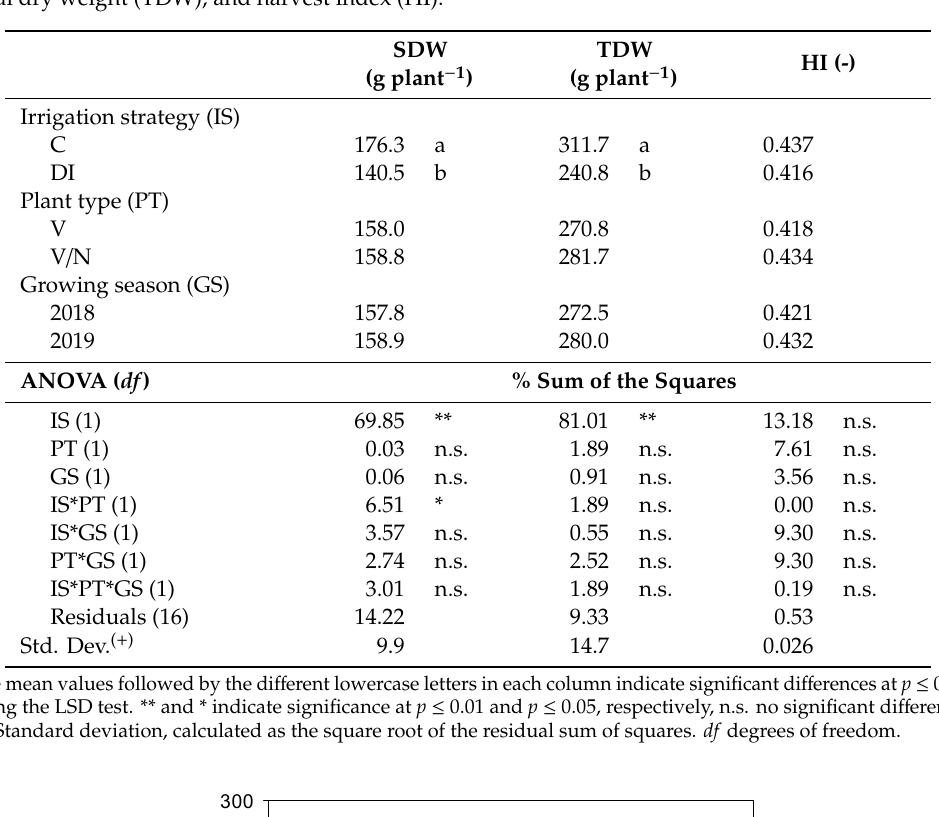
Table 3. Effect of irrigation strategy, plant type, and growing season on the shoot dry weight (SDW), total dry weight (TDW), and harvest index (HI).